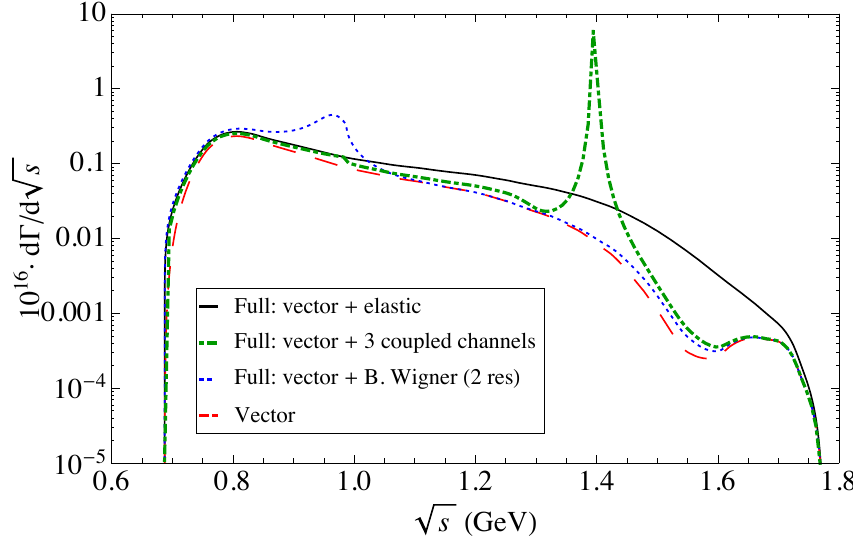
Figure 1. τ − → π − ην τ decay distribution. The vector contribution (red-dashed curve) and the full distribution employing the scalar form factor in its elastic version (black solid curve), in the three coupled-channels analysis (green dot-dashed curve) and using a Breit-Wigner with two resonances (blue dotted curve) are